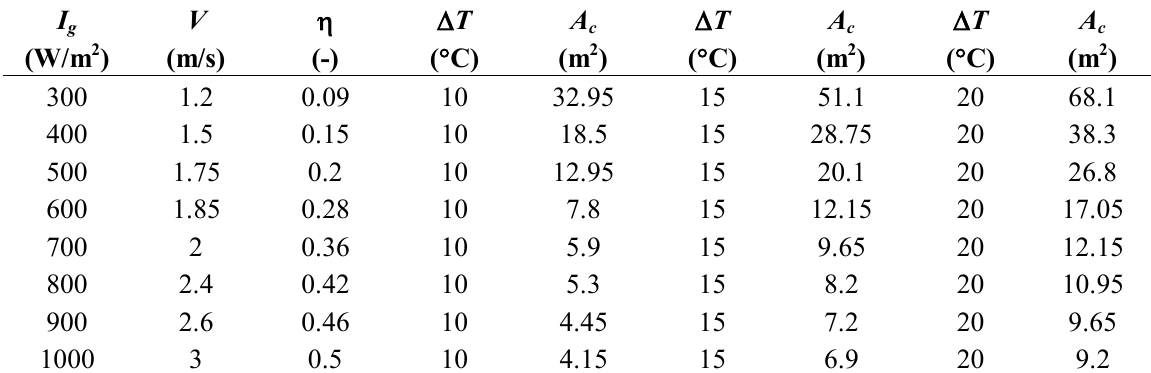
Table 2. Area of solar air collector for three gradient of temperature, for an office